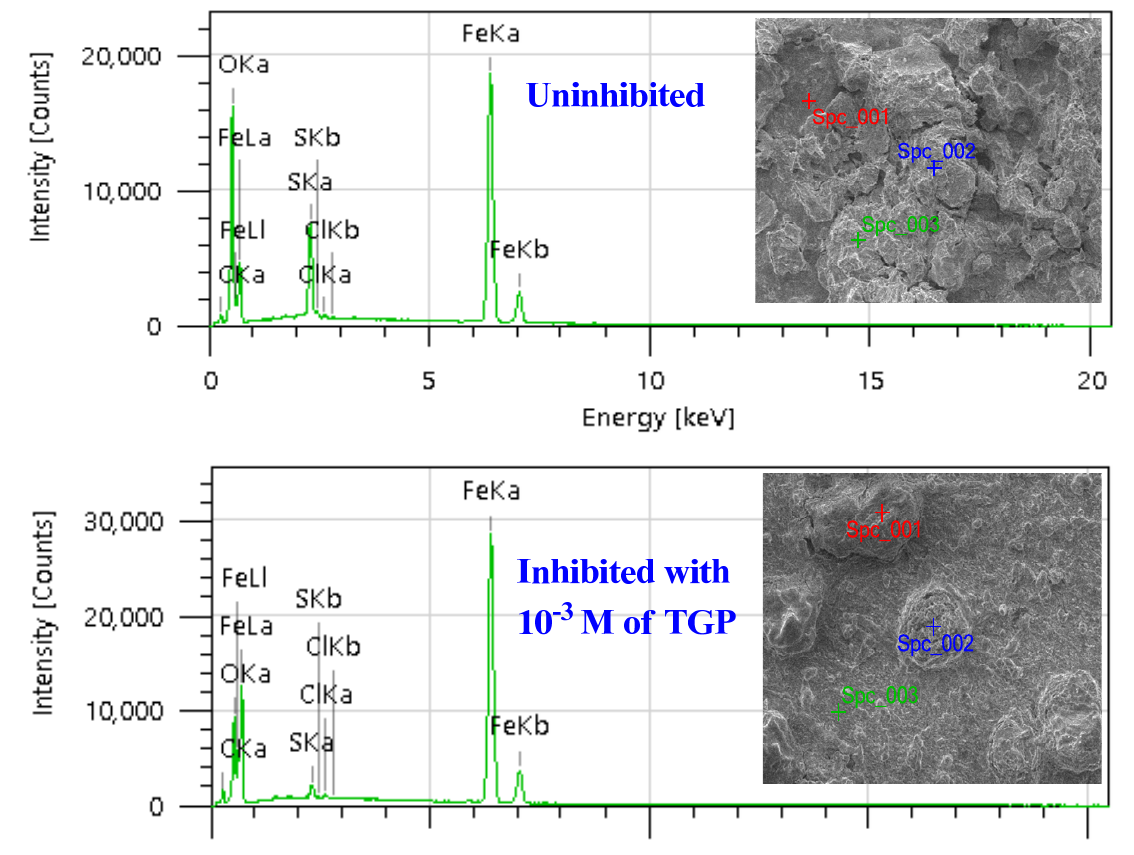
Figure 4. EDS analysis for the uninhibited and inhibited MS electrode area after immersion in 0.5 M H 2 SO 4 with 10 − 3 M of inhibitory resin. Table 3. EDS analysis of MS surface after immersion in 0.5 M H 2 SO 4 at each point with and without 10 − 3 M of TGP.